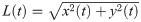
(a) Distance L(t)=x2(t)+y2(t) traveled by single lipid droplet cargoes as a function of time, extracted from experimental trajectories [32]. (b) Time averaged variance (TAVAR) for single experimental trajectories of the lipid droplets as a function of time interval Δ. (c) The mean first passage time (MFPT) as a function the displacement L for single experimental trajectories.